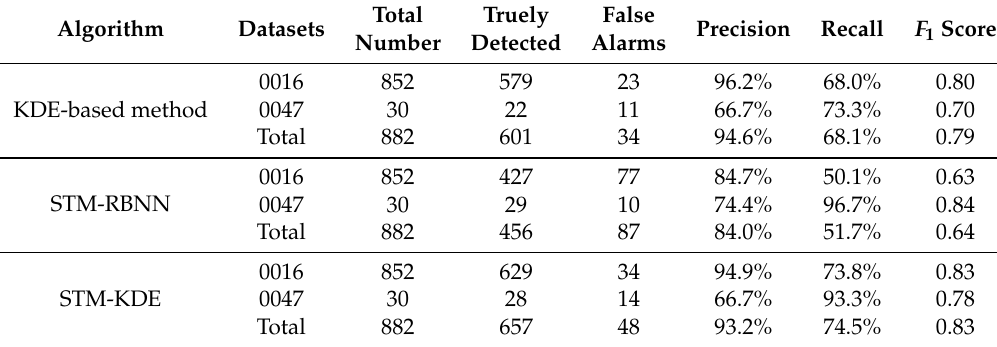
Table 1. Pedestrian detection in the range of 15